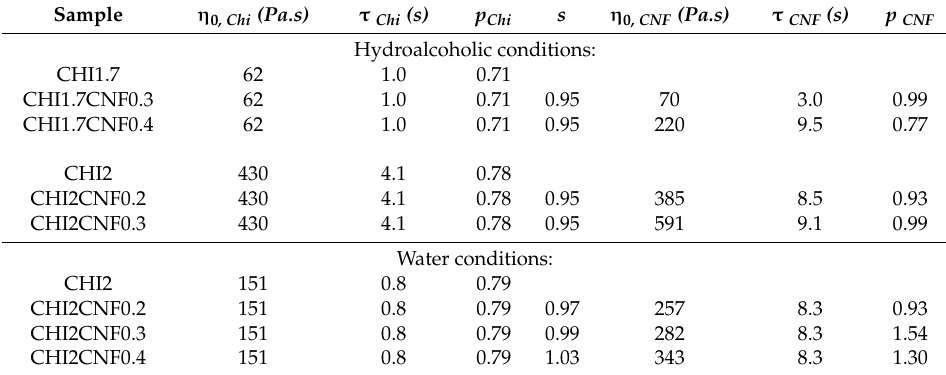
Table 2. Flow parameters determined from the extended flow diagrams of CNF/CHI formulations, by using the Cross model (Equation (1)) for the CHI solutions and the double Cross model (Equation (11)) for the CNF/CHI